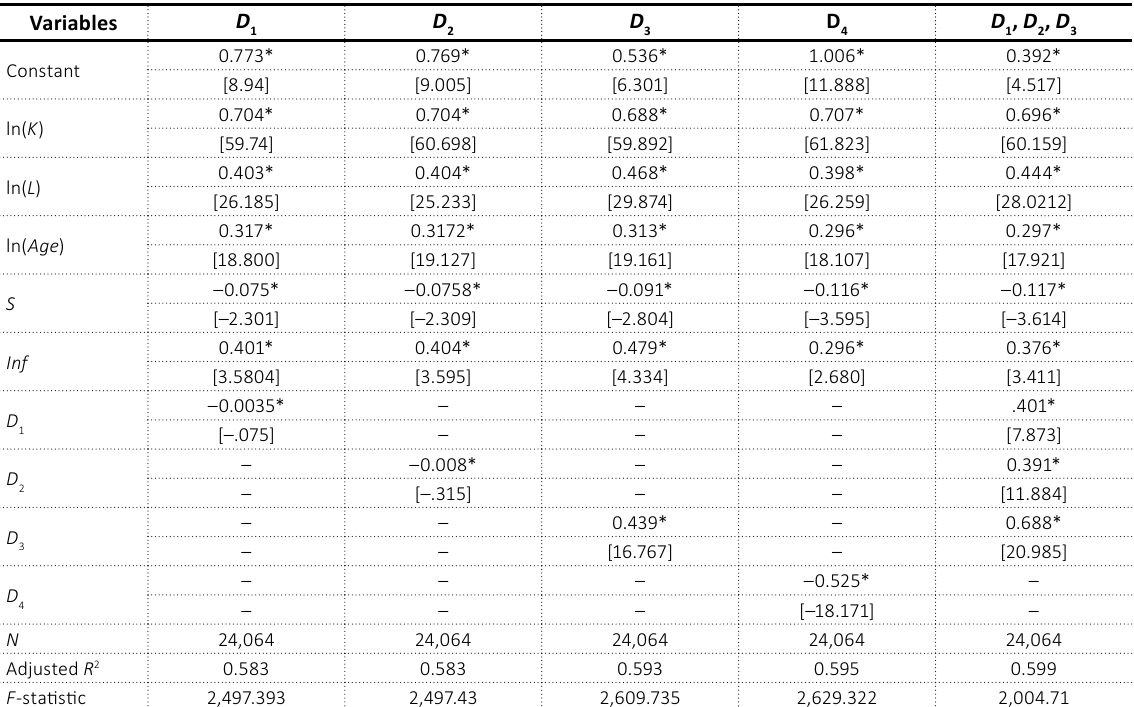
Source: Own edition and calculations